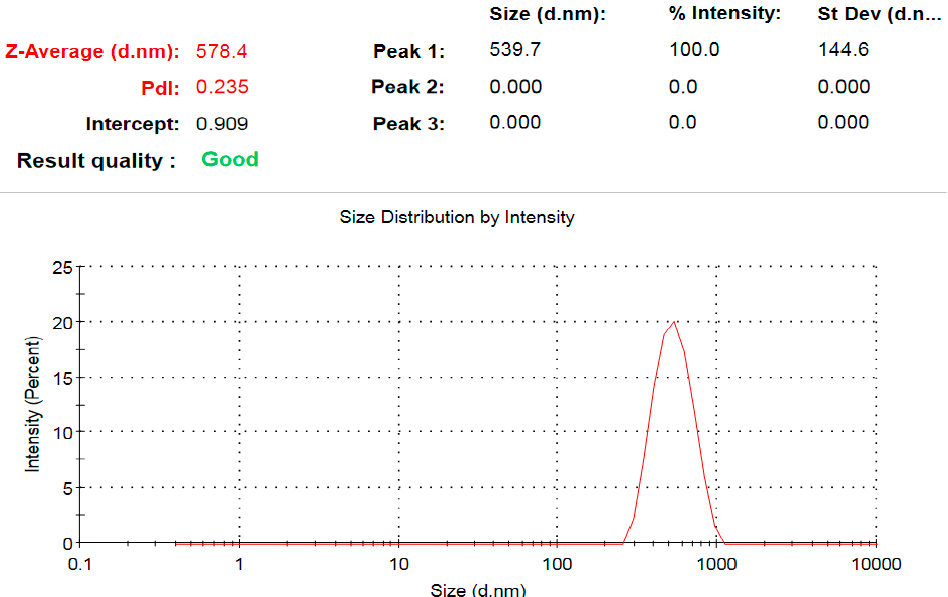
Figure 10. Hydrodynamic diameter of the bioprepared ZnO-NPs.